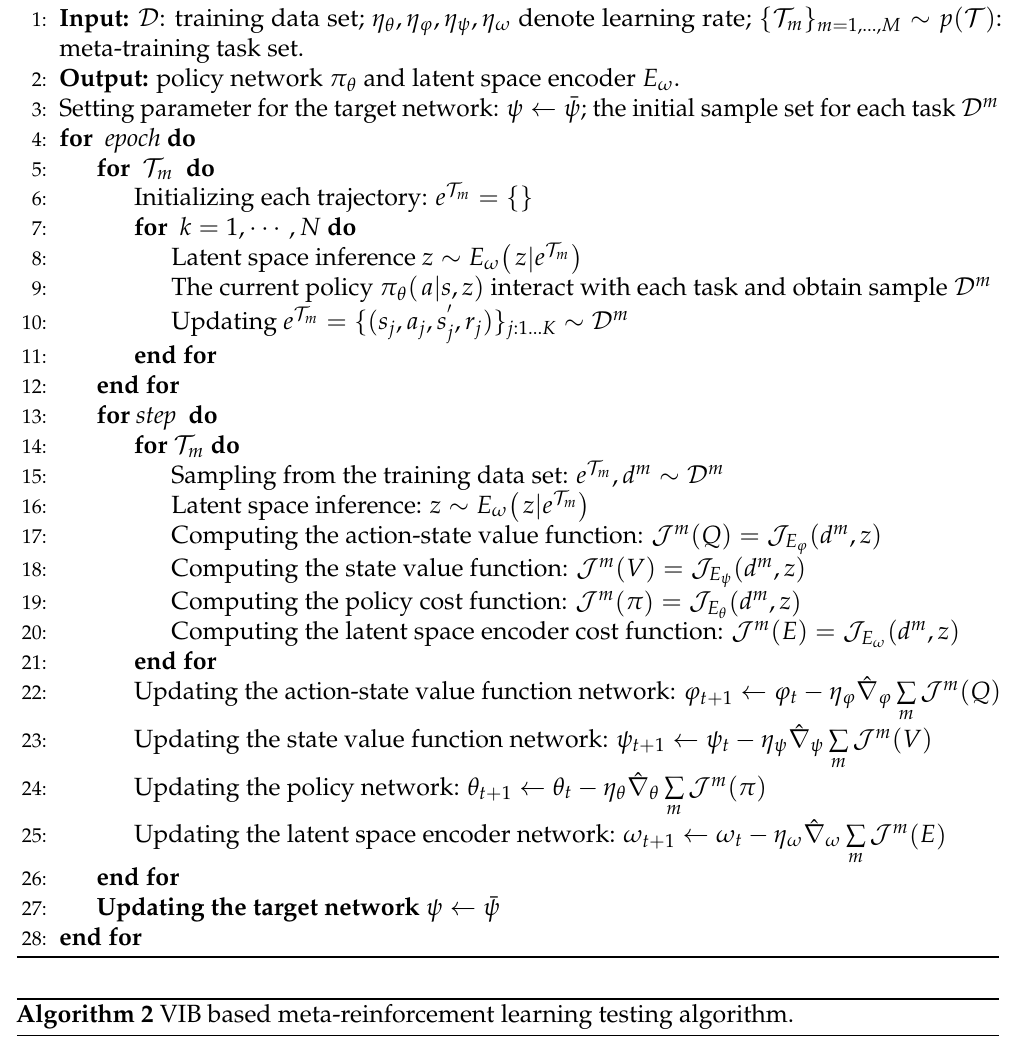
Algorithm 1 VIB based meta-reinforcement learning training algorithm.